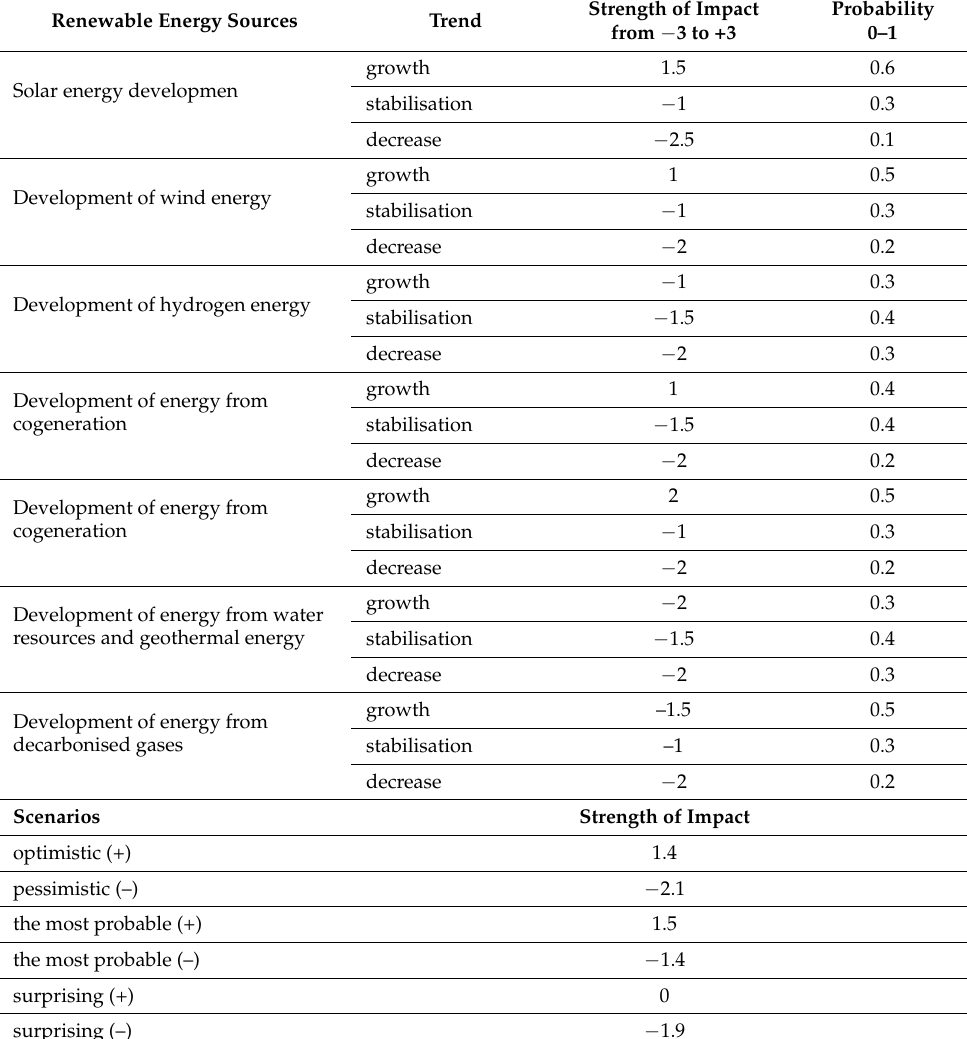
Table 6. Energy portfolio development scenarios based on the renewable sources of the Eastern Poland macroregion in the perspective of